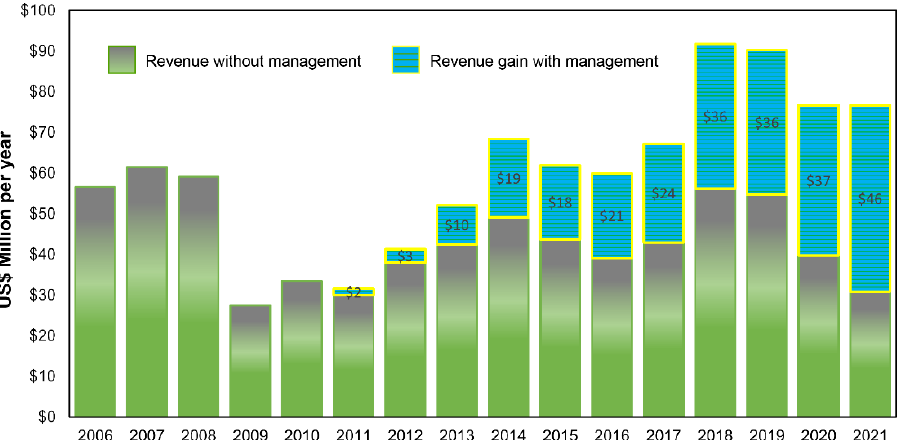
Figure 6. Average statewide revenue (USD million per year) for Hawaii-grown coffee without CBB management from 2006 to 2021 and gain in statewide revenue due to all combined CBB management beginning in 2011.